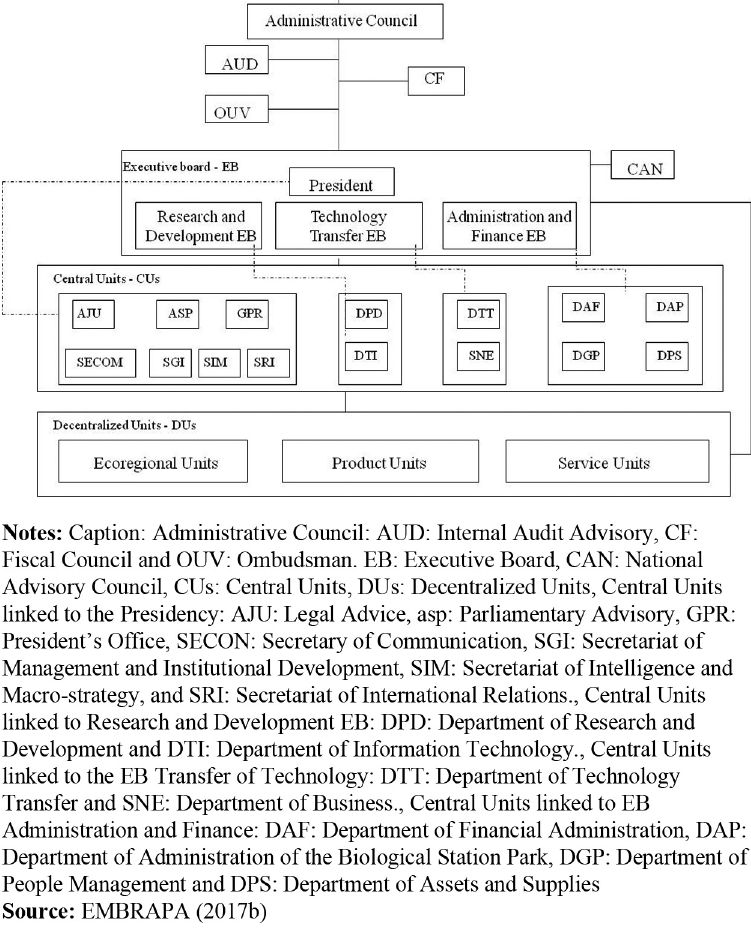
Figure 1. Organization chart of